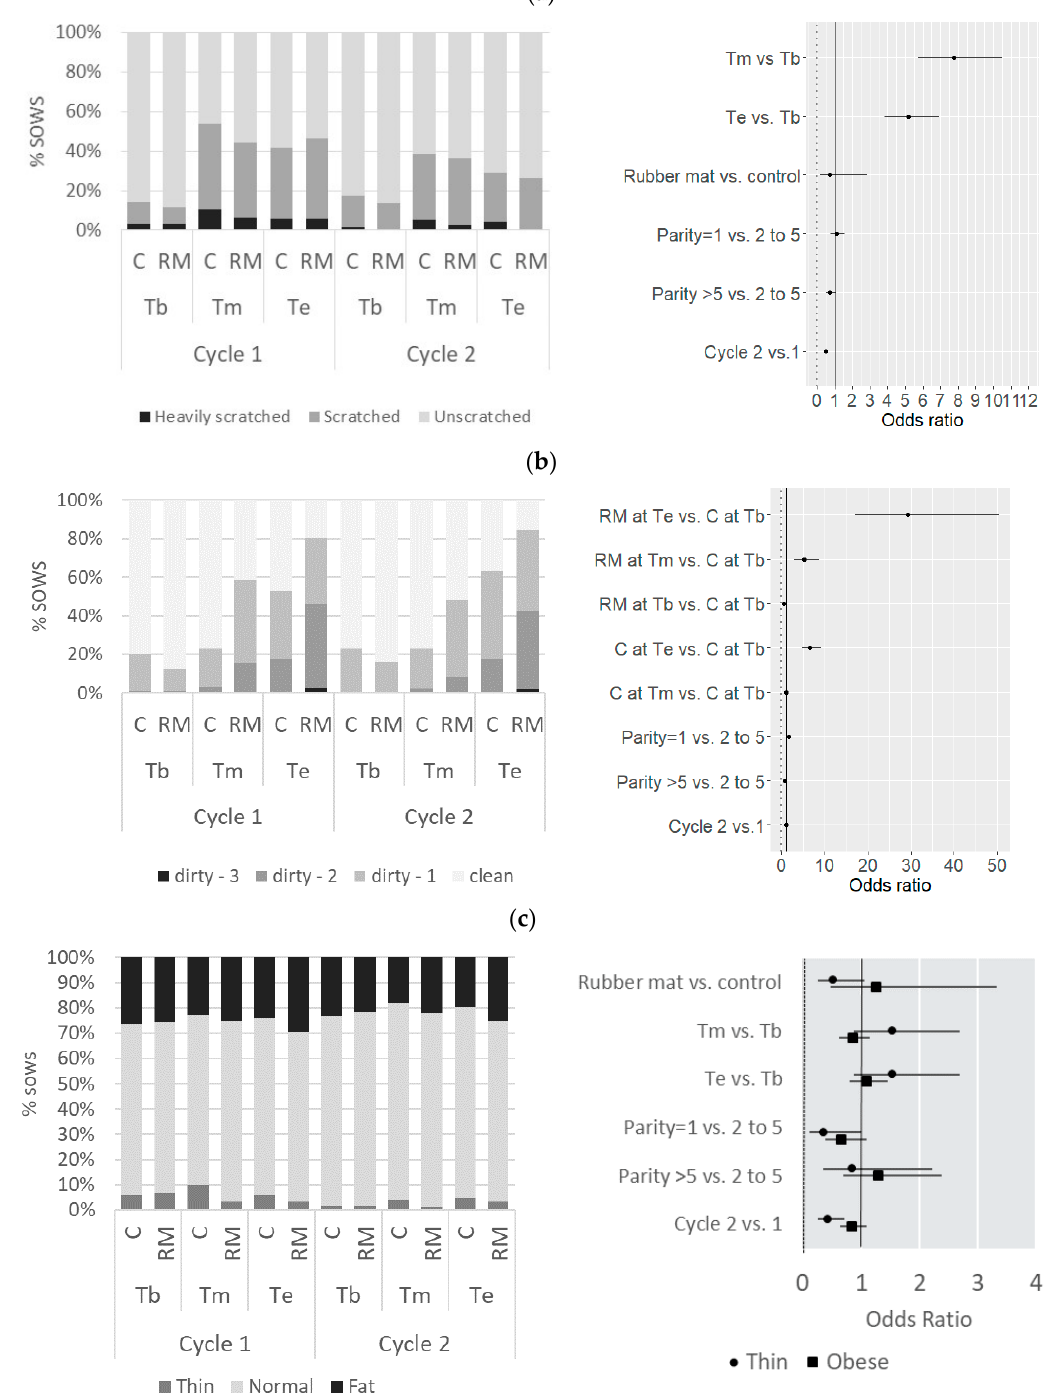
Figure 6. Frequencies of ( a ) body scratches, ( b ) body-cleanliness scores, ( c ) body conditions and estimated odds ratios (with 95% confidence intervals) related to mild or severe forms of these conditions according to the floor type and gestation cycle, from the beginning (Tb) to the end (Te) of the gestation period. RM, rubber mat; C, control.